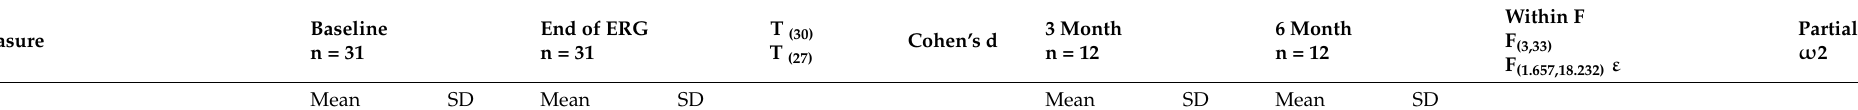
Table 1. Descriptive statistics and